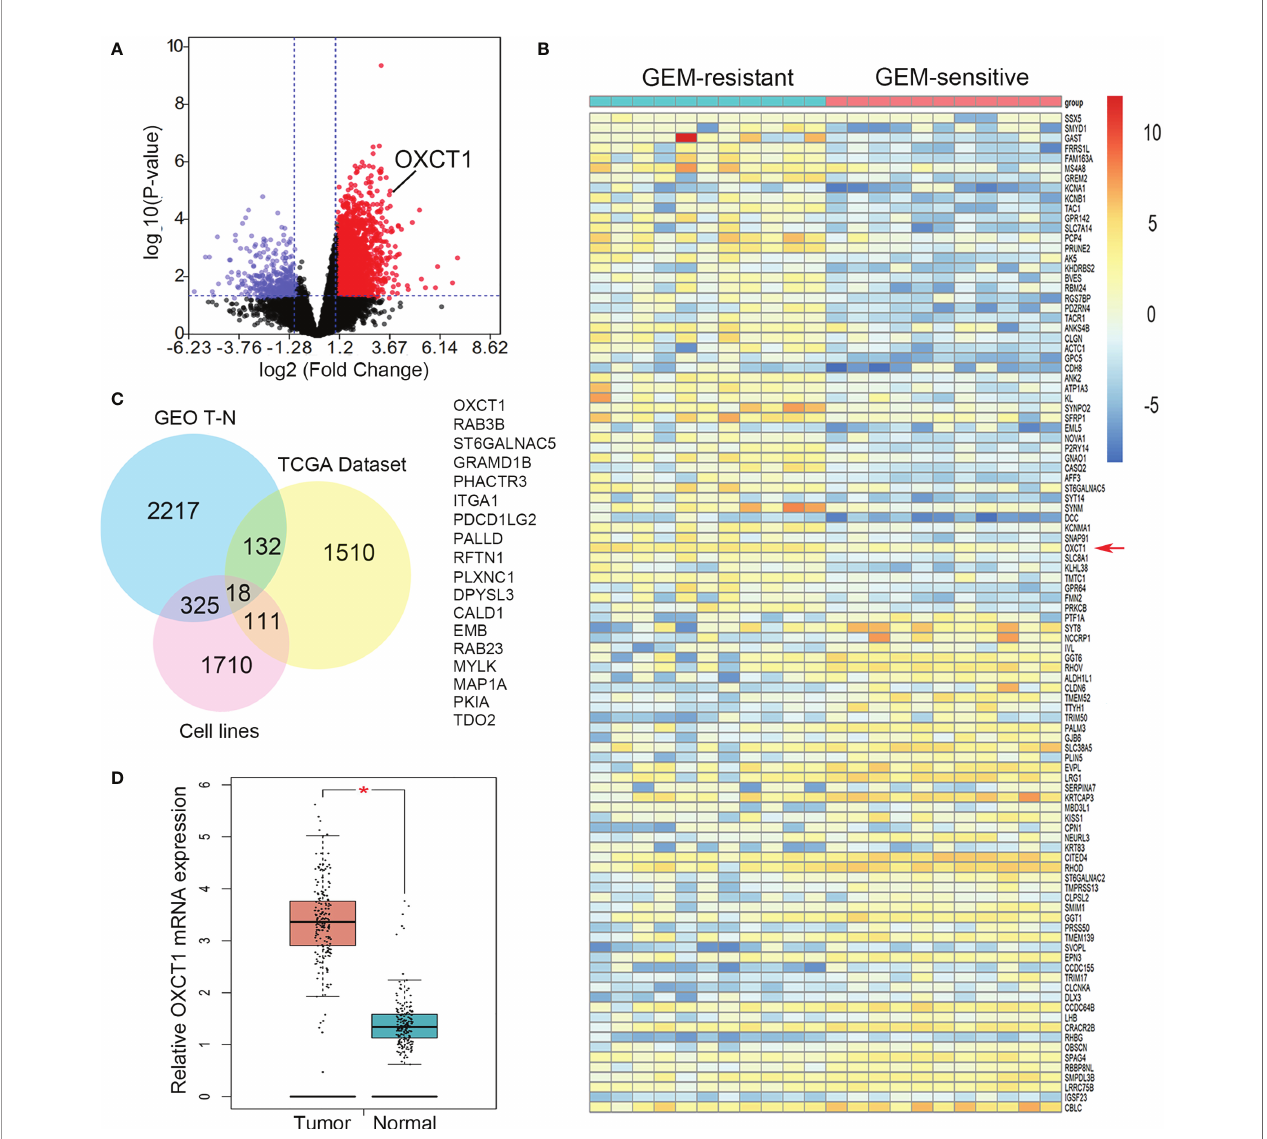
FIGURE 1 | Identi fi cation of OXCT1 through DEG analysis. (A) Volcanoplot depicting the DEGs between GEM-resistant and -sensitive PDAC groups in theTCGA public database. (B) Heatmap showing the expression of the top DEGs. (C) Venn diagram inwhich OXCT1 was identi fi ed as one of the core intersectionsofDEGs inthe GEO and TCGA datasets. (D) Boxplot showingthe basicmRNA expression of OXCT1 in tumor andnormal tissues in the combined TCGA andGTEx datasets. ** P <